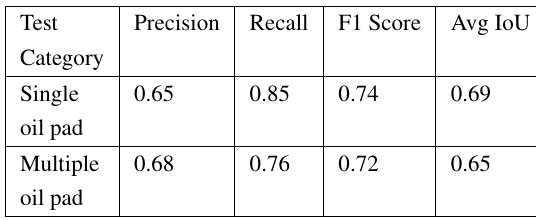
Table 3. Confusion matrix for multiple oil pad set,to see if the model is able to detect multiple oil pads effectively in a single frame.